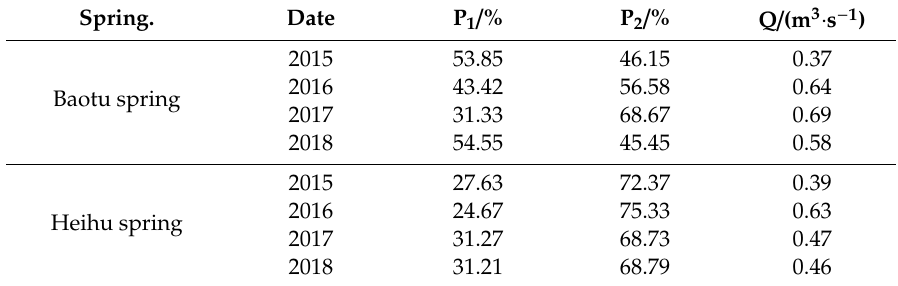
Figure 6. The CFDs of the Heihu Spring. Table 3. Proportion of hidden frequency and peak water flow ratio of the CFDs of the Baotu Spring and Heihu Spring.